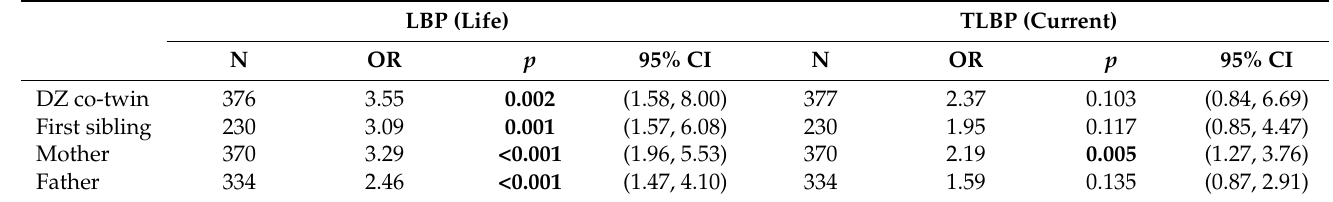
Table 5. Univariate association between a randomly selected twin and each (first-degree) family members.